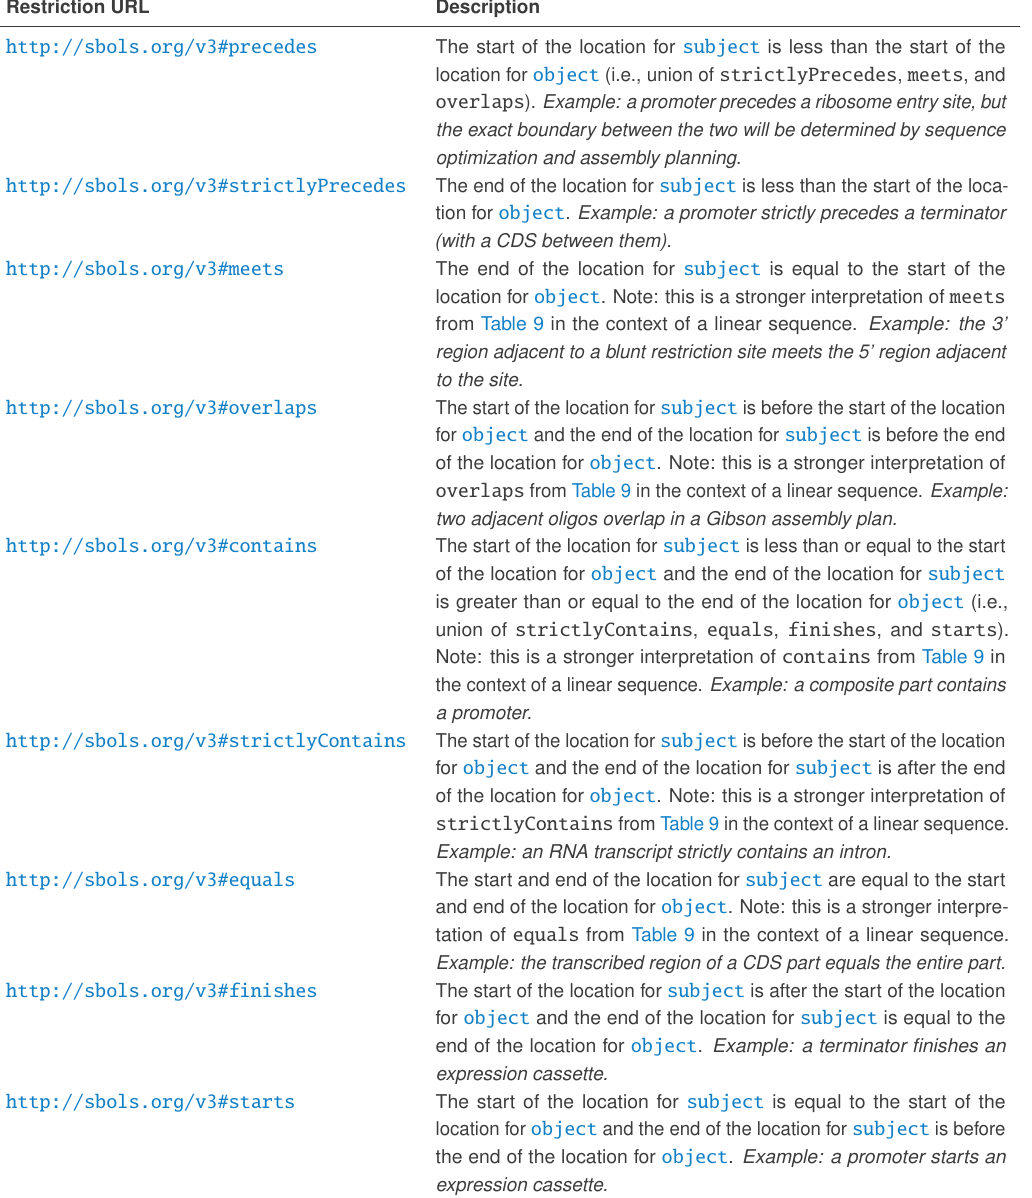
Table 10: RECOMMENDED URL s for expressing sequential relations with the restriction property. Note that these relations are only well-defined when the subject and object can be located on the same Sequence (though this may be something that is inferred rather than known a priori ). In interpreting these relations, it is important to remember that for Range objects, the start and end indices refer to whole bases/residues such that a Range with end equal to 9 meets a Range with start equal to 10, while it strictlyPrecedes a Cut with at equal to 10.